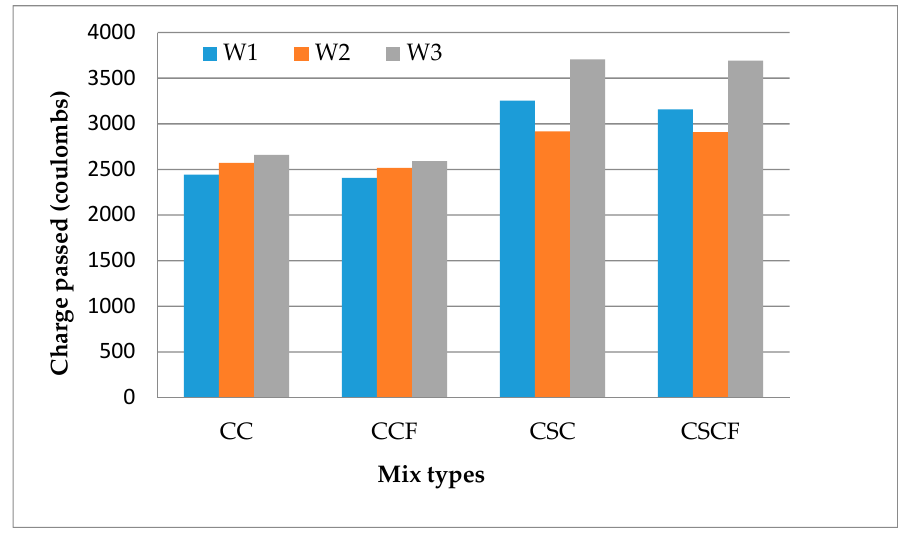
Figure 7. Results of RCPT test.